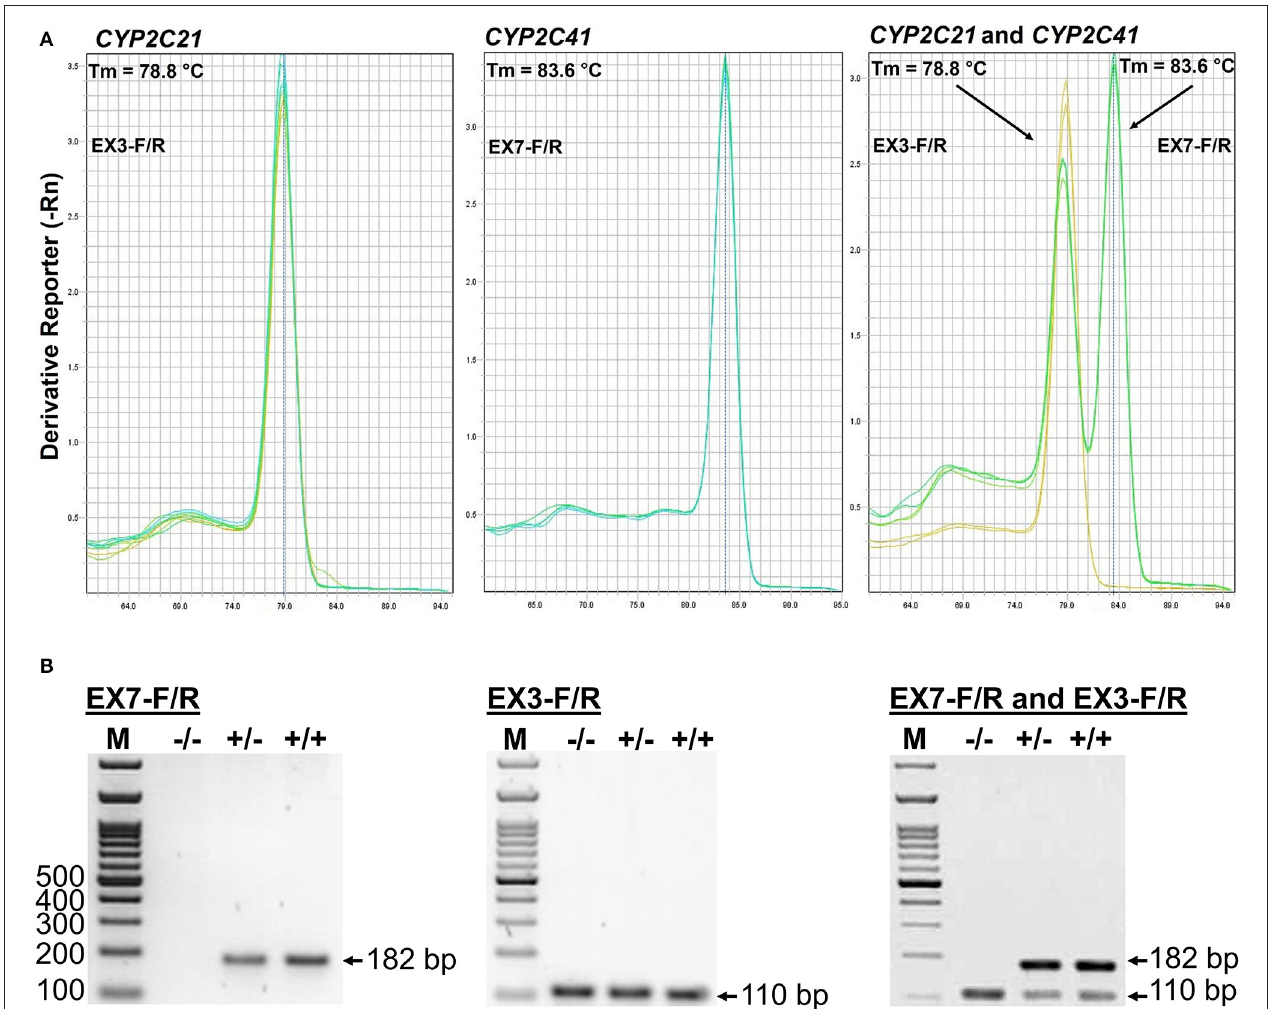
FIGURE 2 | Screening for presence of the CYP2C41 gene. (A) Multiplex PCR and melting curve analysis for simultaneous detection of the CYP2C21 (primers EX3-F/R, Tm = 78.8 ◦ C) and CYP2C41 (primers EX7-F/R, Tm = 83.6 ◦ C) genes. Multiplex PCR with primers EX3-F/R and EX7-F/R revealed identical melting curves as the single gene PCRs with primers EX3-F/R or EX7-F/R. (B) The PCR products were separated on 2% agarose gels followed by visualization with ethidium. Representative data for all three CYP2C41 genotypes: ( + / + ), homozygous positive; ( + /–), heterozygous; and (–/–), homozygous negative. Amplification with the primers EX7-F/R revealed PCR fragments of 182 bp, indicating the presence of the CYP2C41 gene, and amplification of CYP2C21 exon 3 with the primers EX3-F/R revealed 110 bp fragments. By using multiplex PCR, both fragments were detected. M, molecular weight DNA